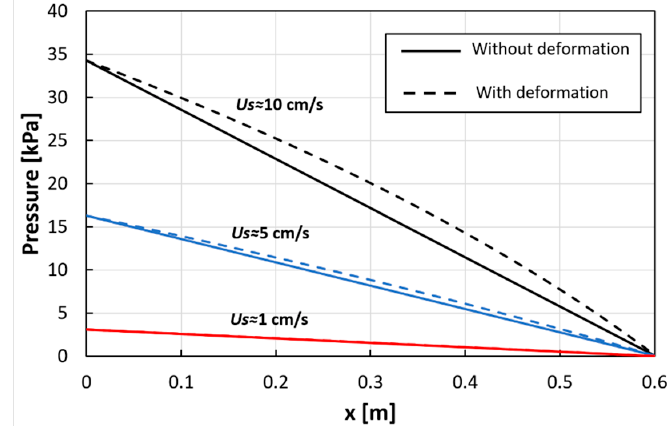
Figure 14. Pressure profiles along the x -direction near the lower edge ( y = 0.55 m) of the concentrate channel for the cross flow configuration and (cid:104) U s (cid:105) ≈ 1, 5, and 10 cm / s. Profiles are reported both in the presence and absence of membrane deformation.